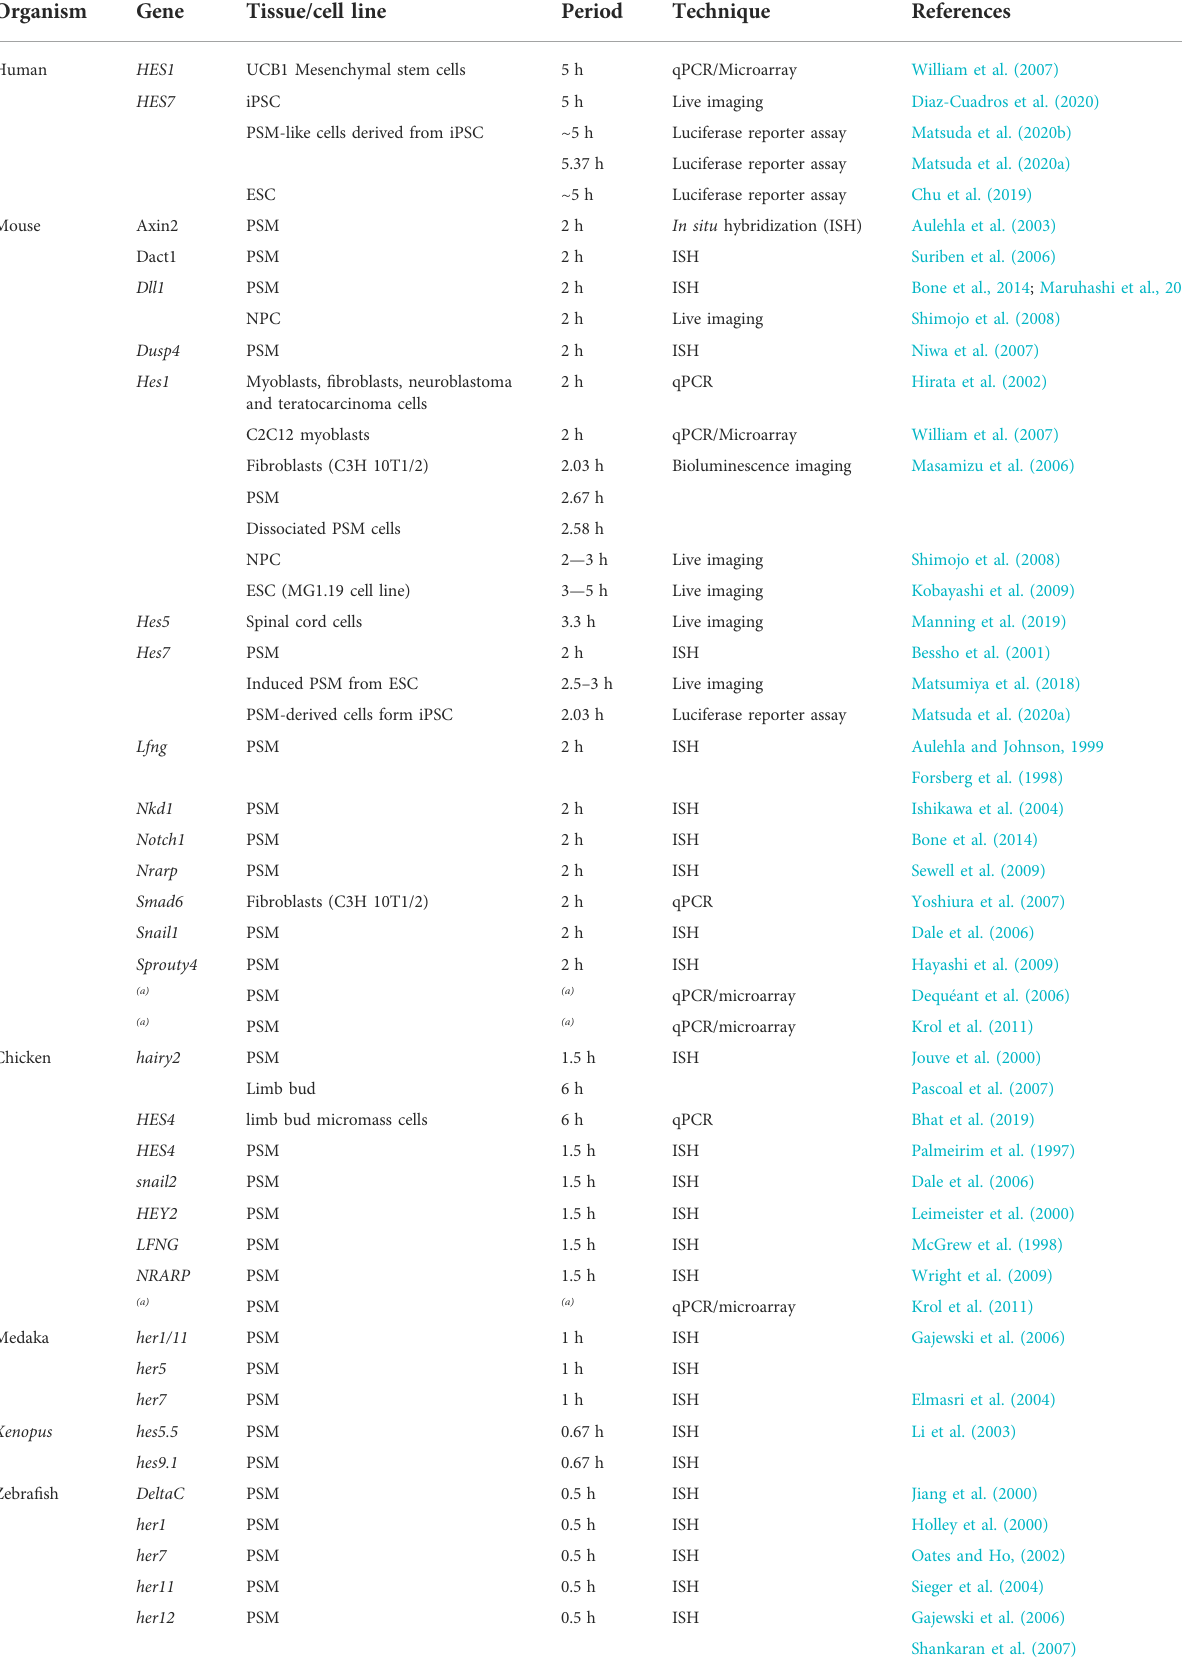
TABLE 2 Periodicity of gene expression oscillations.